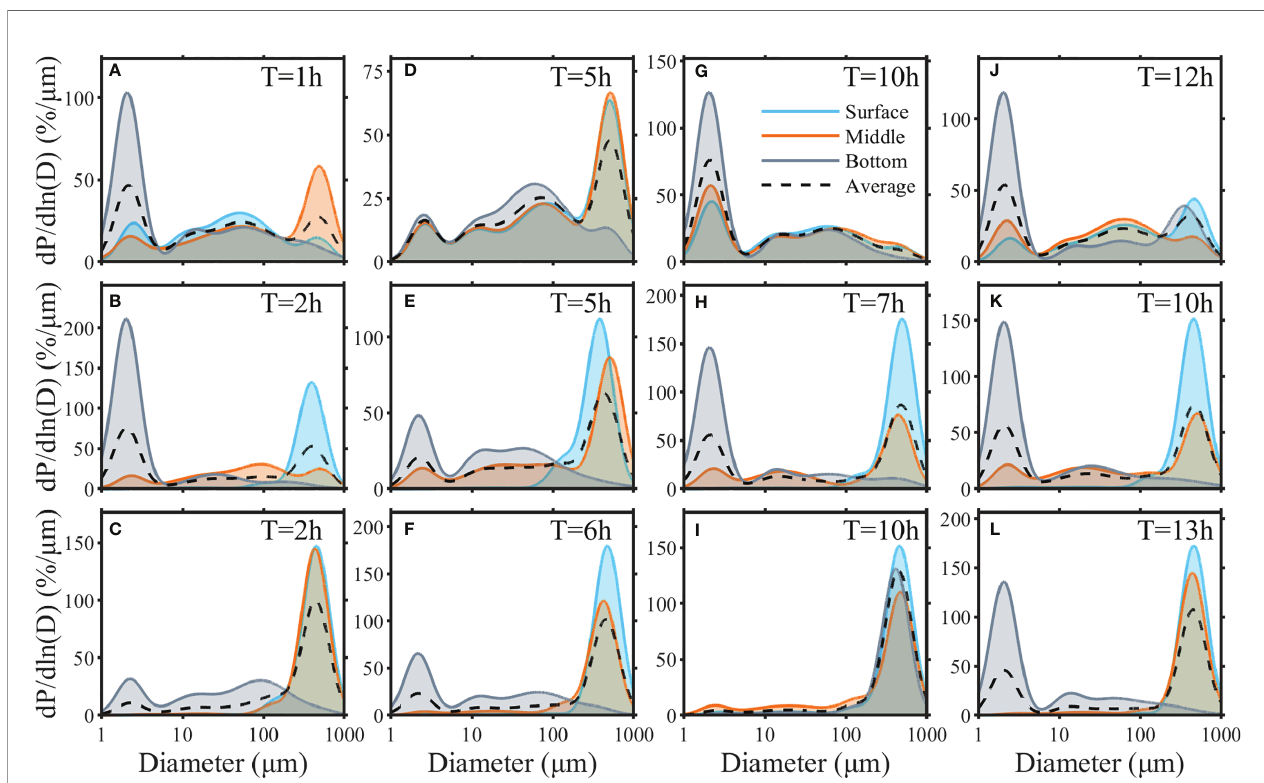
FIGURE 7 | Normalized measured FSDs among the water column (black dash lines) and surface (blue lines), middle (orange lines), and bottom (gray lines) layers and characteristic times; (A, D, G, J) , (B, E, H, K) , and (C, F, I, L) represent the spring, middle, and neap tides, respectively; (A – C) show the fl ood peak fl ow, (D – F) show the fl ood to ebb slack water, (G – I) show the ebb peak fl ow, and (J – L) show the ebb to fl ood slack water. Here, dp/dln(D) is the volumetric percentage normalized by the width of the size interval on the log